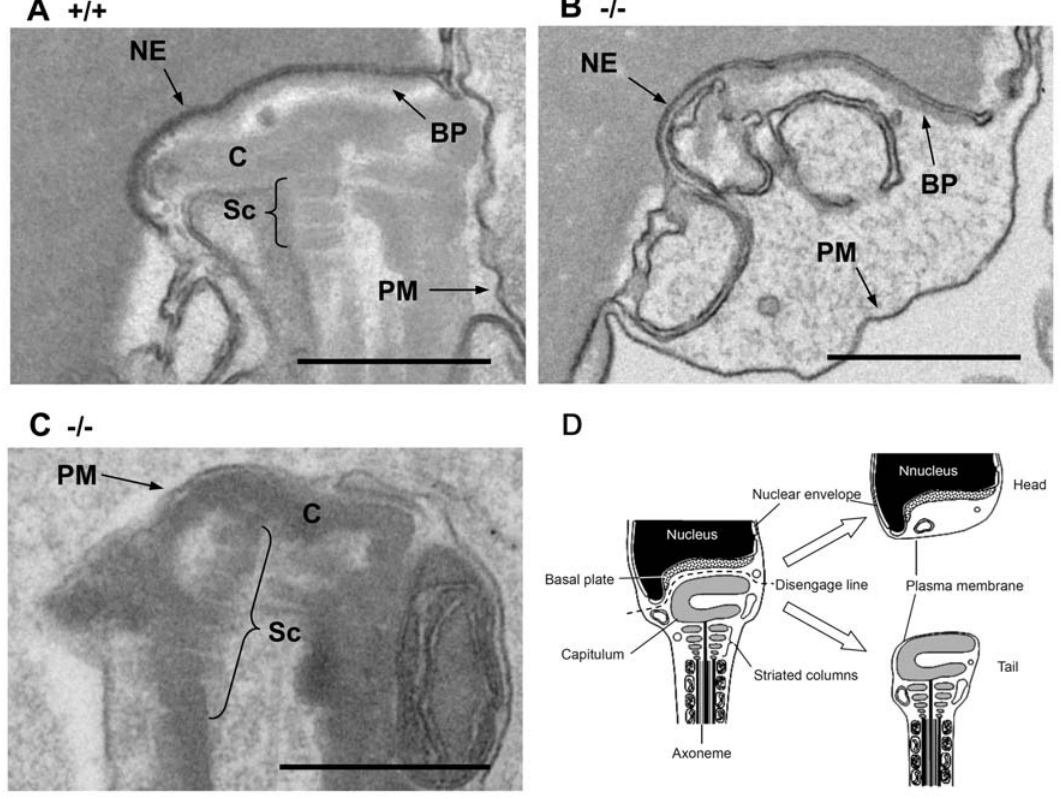
Figure 4. Morphology of mature sperm in the cauda epididymis. The image in (A) shows the neck region of a sperm cell from a wild-type mouse. In the implantation fossa, several typical components of the connection between head and tail can be identified: the basal plate (BP), the capitulum (C), and striated columns (Sc). NE: nuclear envelope, PM: plasma membrane. The image in (B) shows the neck region of a separated head obtained from a mutant mouse. The basal plate (BP) is apparent at the outer nuclear membrane, but the remaining connecting components ( i.e. , the capitulum and striated columns) are absent. The image in (C) shows the distal end of the separated tail. Note that the capitulum (C) and striated columns (Sc) are present. Bar=0.5 m m. (D) Schematic presentation of mature sperm in OAZ-t null mutant.